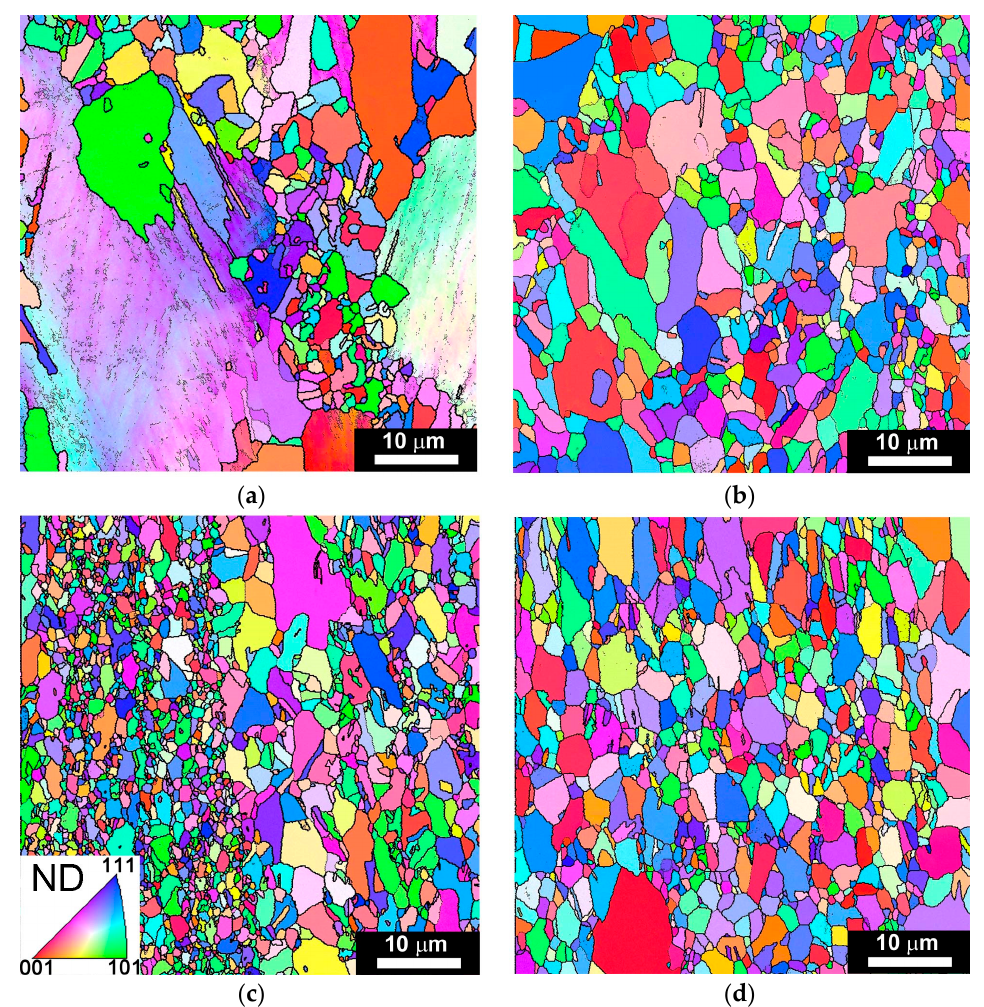
Figure 5. Annealed microstructures of a high-Mn steel subjected to cold rolling followed by annealing; ( a ) rolling reduction of 40%, annealing at 873 K; ( b ) rolling reduction of 60%, annealing at 873 K; ( c ) rolling reduction of 80%, annealing at 873 K; ( d ) rolling reduction of 80%, annealing at 973 K.